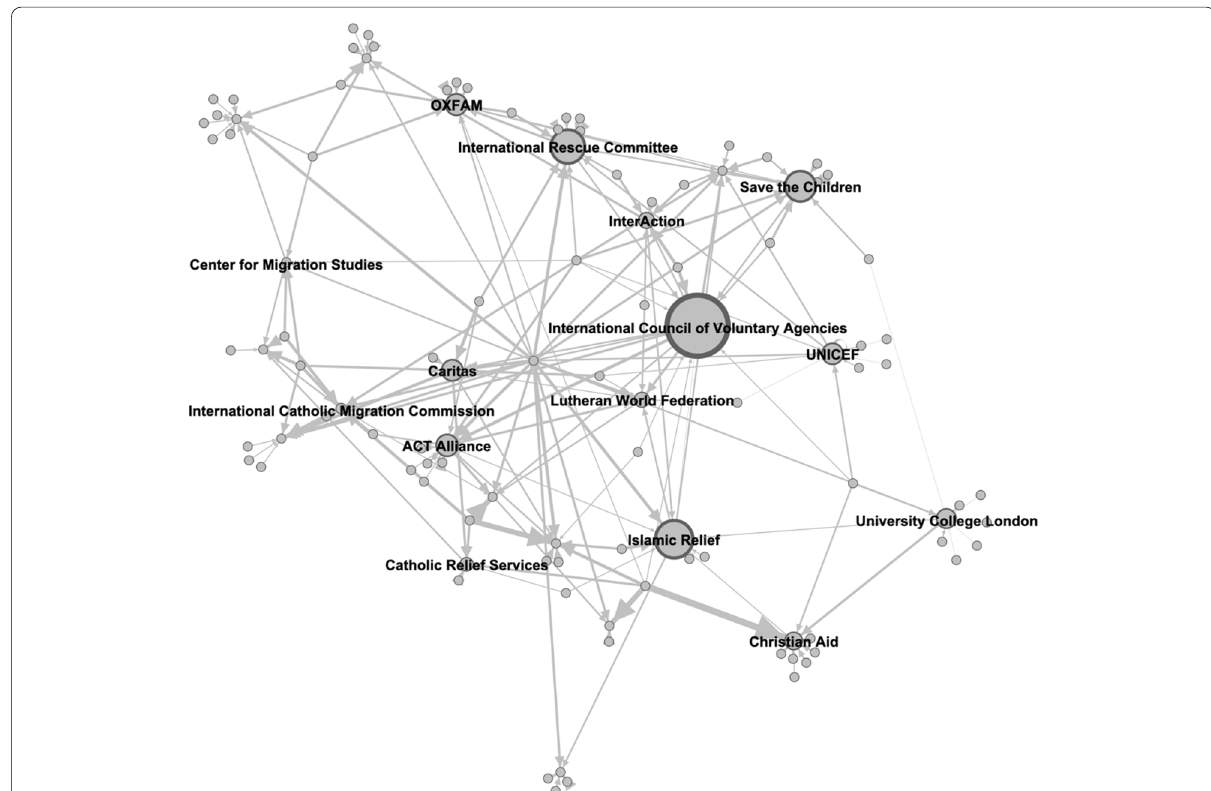
Fig. 3 Policy network showing betweenness centrality, node size scaled by betweenness centrality